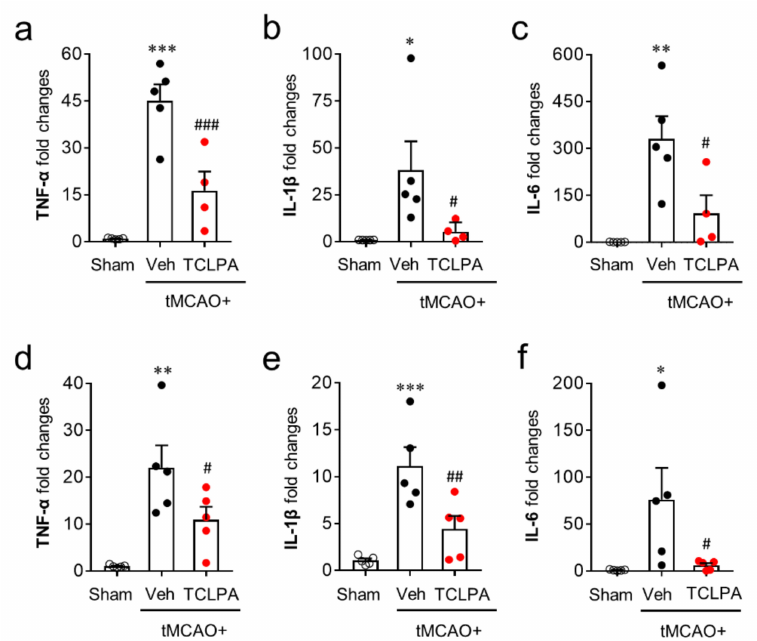
Figure 6. LPA 5 antagonism attenuates mRNA expression levels of pro-inflammatory cytokines in the injured brain after tMCAO challenge. Mice were challenged with tMCAO. TCLPA5 (TCLPA: 10 mg / kg, i.p.) was administered immediately after reperfusion and mRNA expression levels of pro-inflammatory cytokines (TNF- α , IL-1 β , and IL-6) were determined using qRT-PCR analysis at one ( a – c ) and three days ( d – f ) after tMCAO challenge. n = 4 ~ 5 mice per group. * p < 0.05, ** p < 0.01, and *** p < 0.001 versus sham; # p < 0.05, ## p < 0.01, and ### p < 0.001 versus vehicle-administered tMCAO